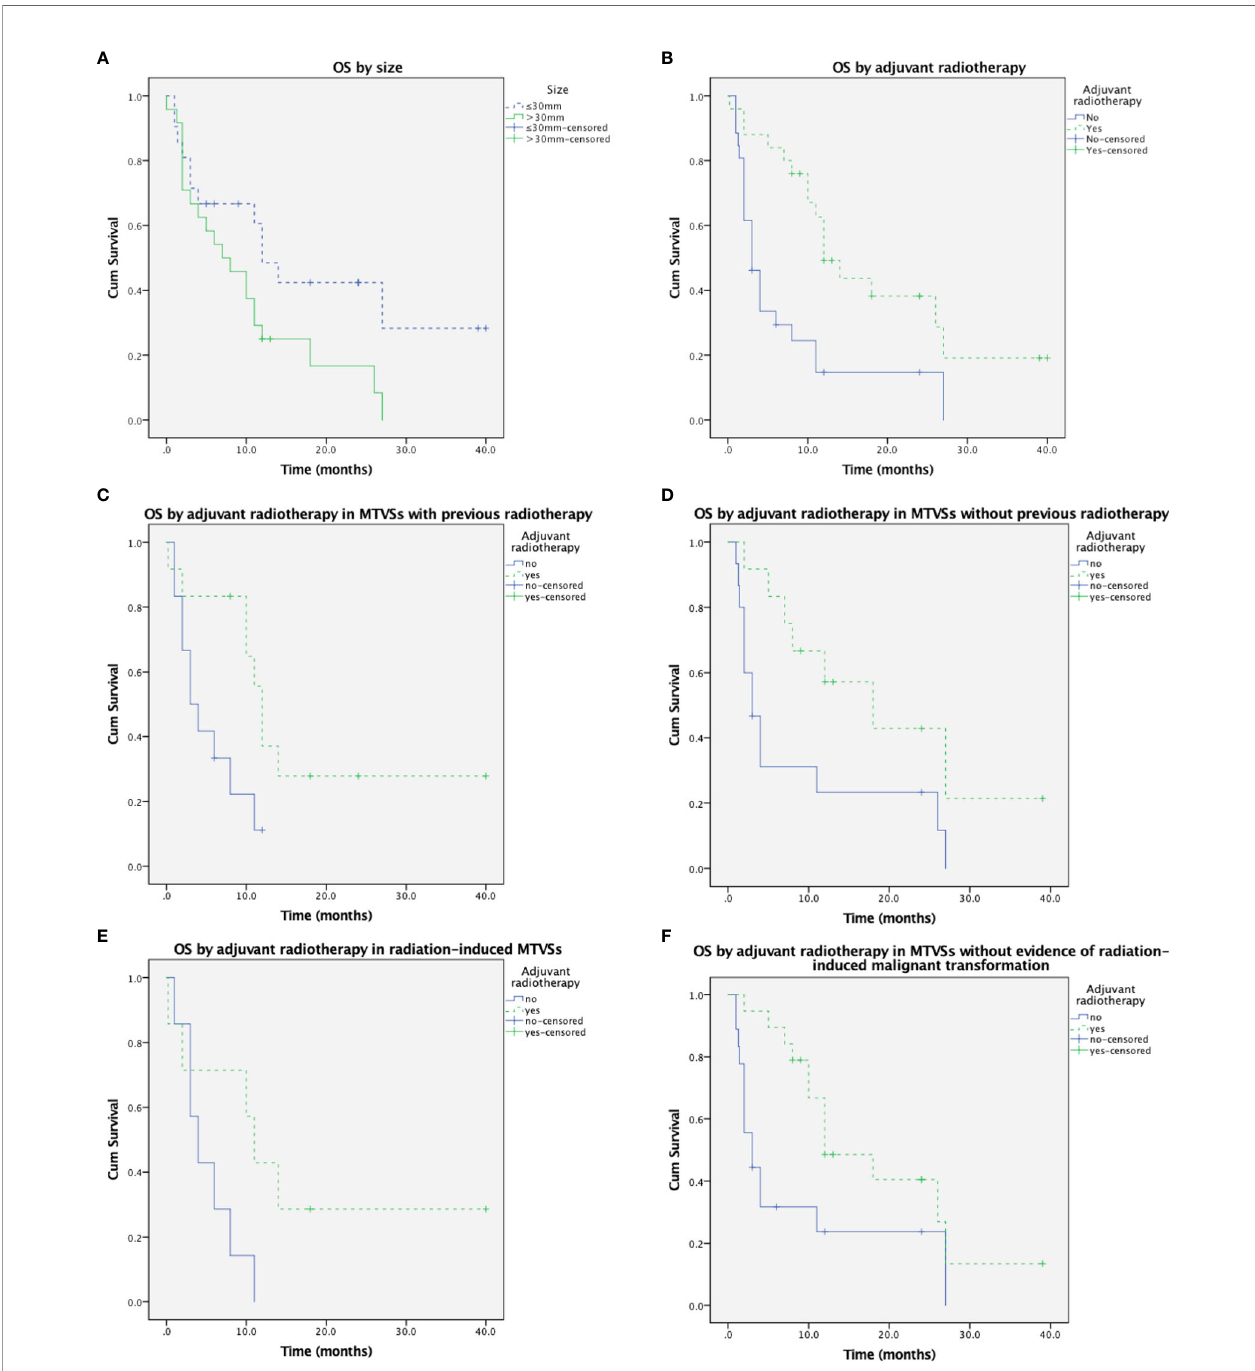
FIGURE 2 | Cumulative overall survival in MTVSs. (A) Kaplan-Meier analysis of overall survival in 71 MTVSs patients based on size ( ≤ 30mm vs. >30mm). Tumor size>30mm was signi fi cantly associated with shorter OS time (p = 0.047). (B) Kaplan-Meier analysis of overall survival in 71 MTVSs patients based on postoperative adjuvant radiotherapy (yes vs. no). Patients underwent postoperative adjuvant radiotherapy was signi fi cantly associated with longer OS time (p = 0.001). (C) Kaplan-Meier analysis of overall survival in 35 MTVSs with previous radiotherapy revealed patients underwent postoperative adjuvant radiotherapy were signi fi cantly associated with longer OS time (p = 0.023). (D) Kaplan-Meier analysis in 35 MTVSs without a radiation treatment history revealed signi fi cantly longer OS in patients received postoperative adjuvant RT (P=0.024). (E) Kaplan-Meier analysis of overall survival in 20 radiation-induced MTVSs depicted postoperative adjuvant RT could not signi fi cantly improve OS time (p =0.073). (F) Kaplan-Meier analysis of the other 51 cases without evidence of radiation-induced MTVSs showed signi fi cantly longer OS in patients received postoperative adjuvant RT compared with those without postoperative adjuvant RT